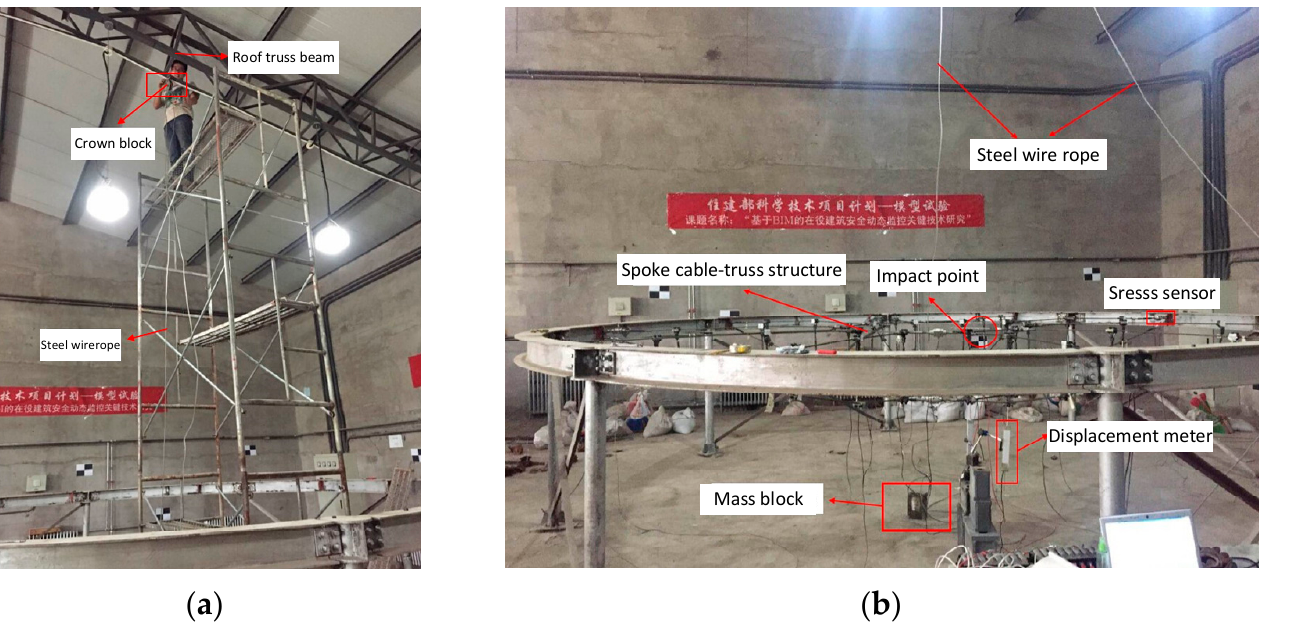
Figure 8. Actual model test. ( a ) Loading device for impact test; ( b ) Test structure model.